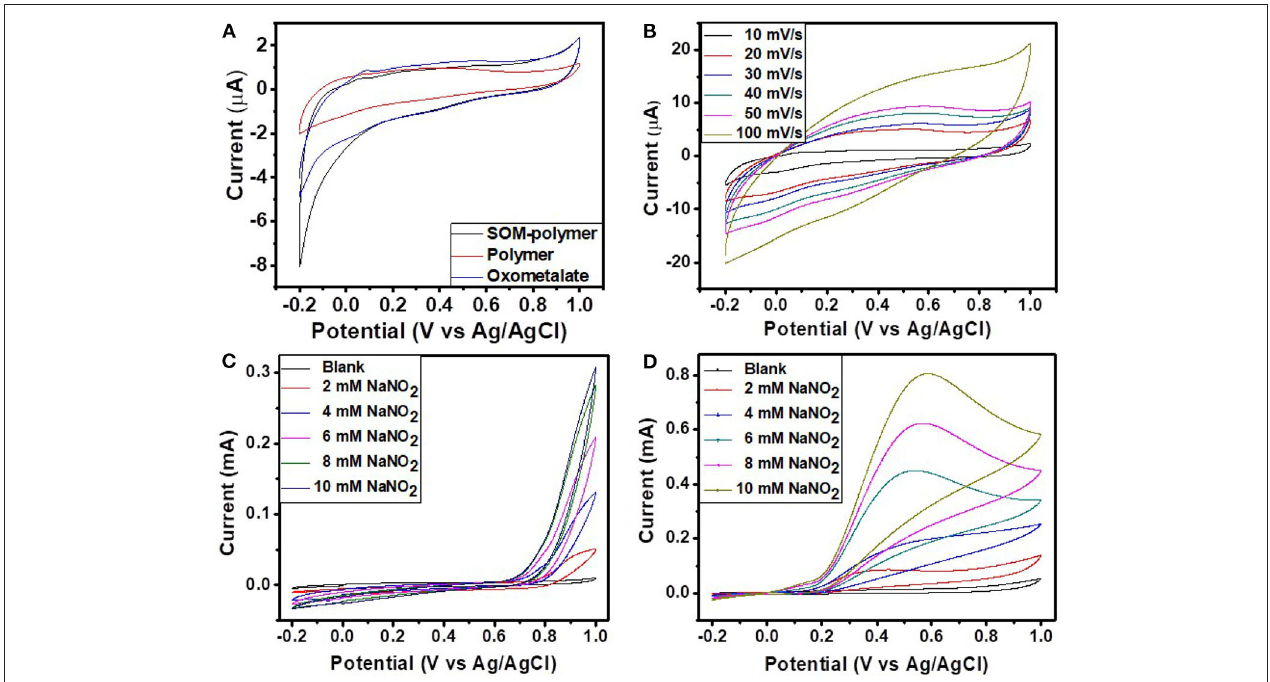
FIGURE 10 | (A) The comparison CVs of SOM-polymer, pure polymer, and pure oxometalate at a scan rate of 10 mV/s. (B) The CVs of the SOM-polymer hybrid at different scan rates ranging from 10 to 100 mV/s. CVs of (C) pure polymer and (D) SOM-polymer hybrid with different amounts of NaNO 2 . All of the electrochemical measurements were done in 0.5M H 2 SO 4 using Ag/AgCl as a reference